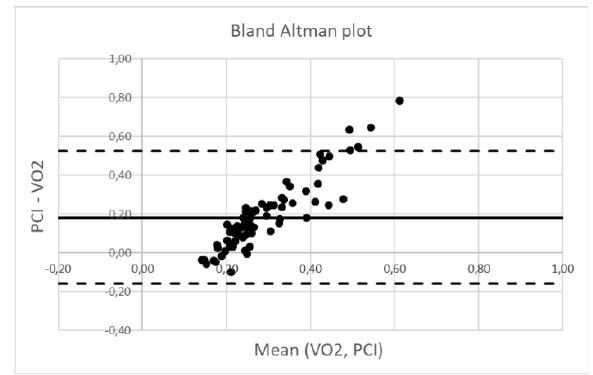
Figure 1: Correlation between PCI and ECW during over-ground walking test, (p=0.003). The mean values of TWT0% were ECW=0.307±0.084 ml/kg/m and PCI=0.465±0.205 (beats/m), p=0.075 (Figure 2).